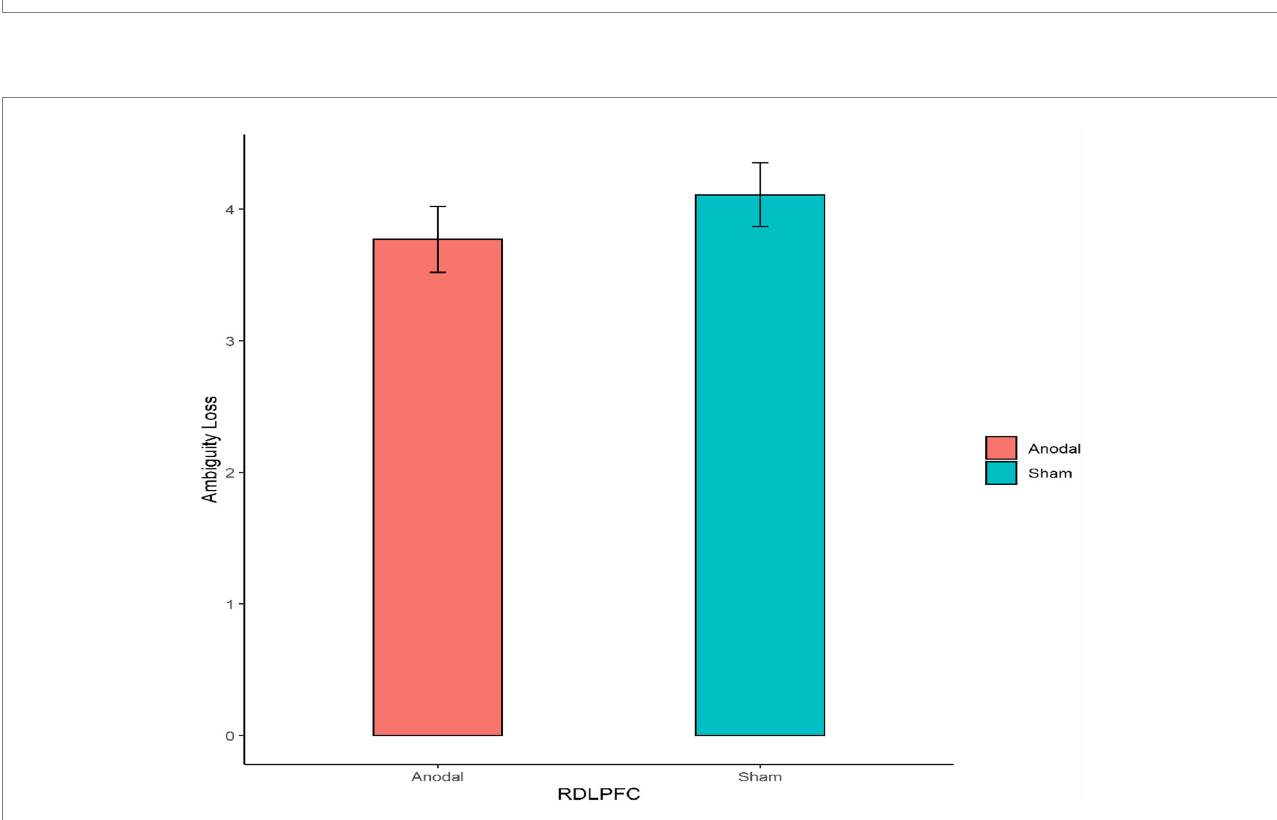
FIGURE 5 The degree of the participants’ attitudes toward ambiguity gain under different left DLPFC stimulation conditions. Error bars represent standard errors.